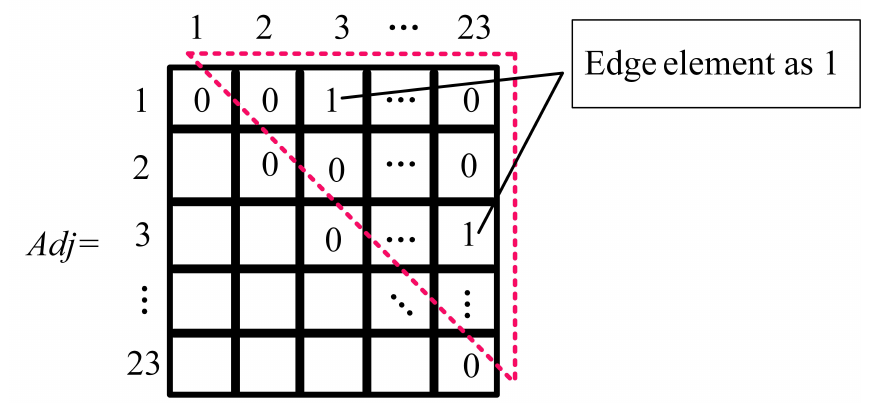
Figure 6. Adjacent